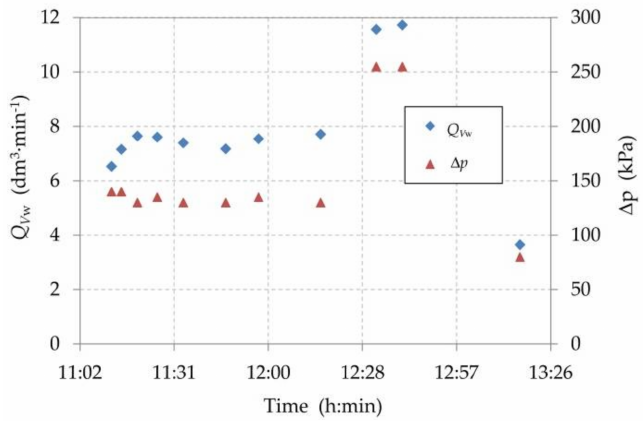
Figure 5. Volume flow and the difference between the inlet and outlet cooling water pressures.